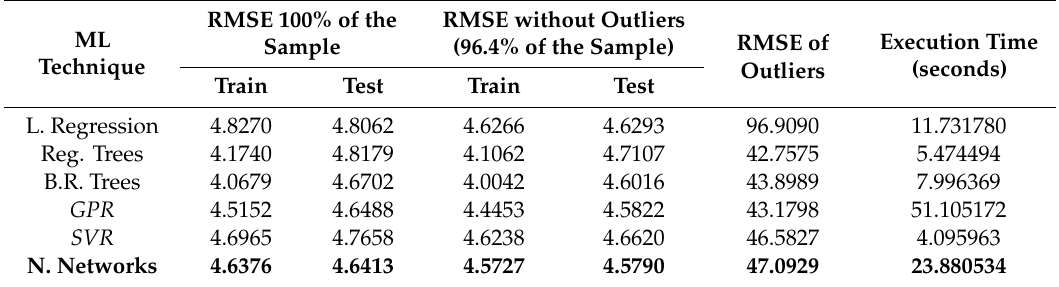
Table 12. BMI-CTDI VOL results for men’s Abdomen